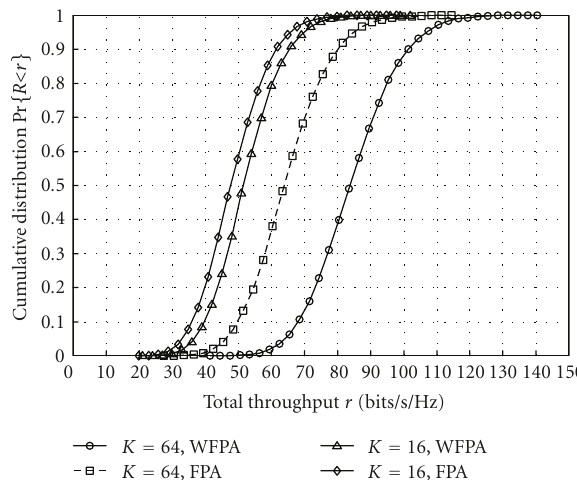
Figure 10: Cumulative distribution of total throughput per cell with code constraints for FPA and WFPA (BCRGA in